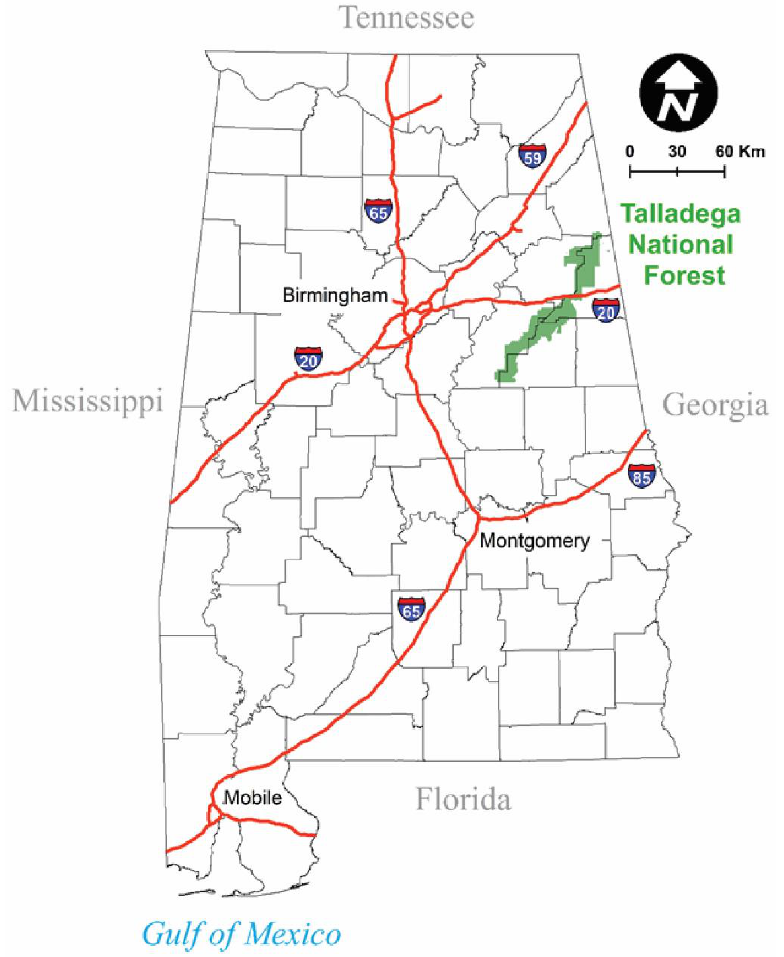
Figure 1. The location of the Talladega National Forest in northeast Alabama, USA.